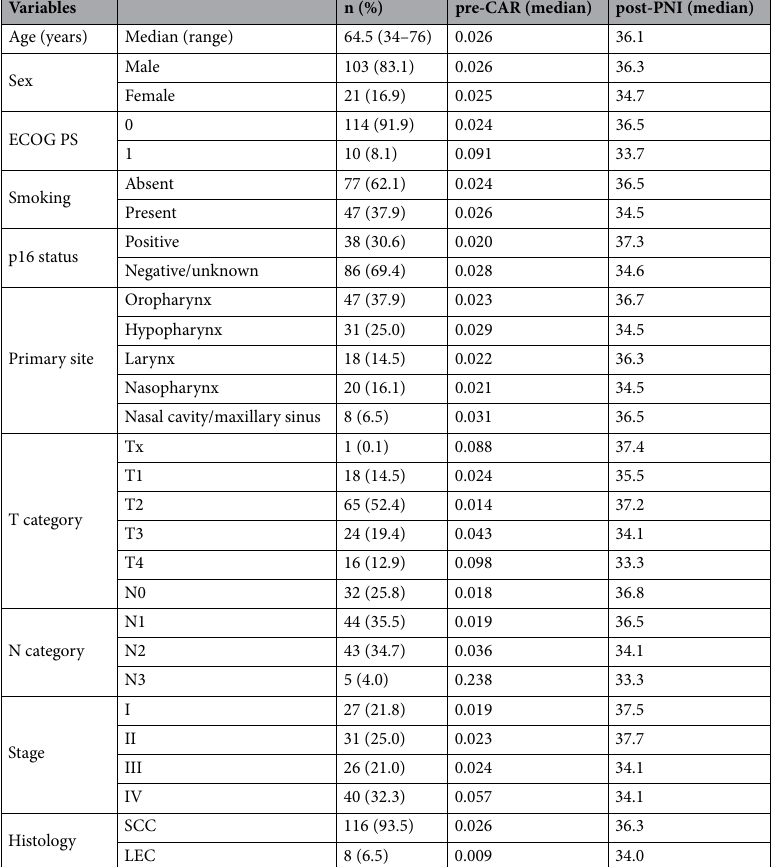
Table 1. Clinical characteristics of the 124 patients included in this study. CAR C-reactive protein/albumin ratio, PNI prognostic nutritional index, SCC squamous cell carcinoma, LEC lymphoepithelial